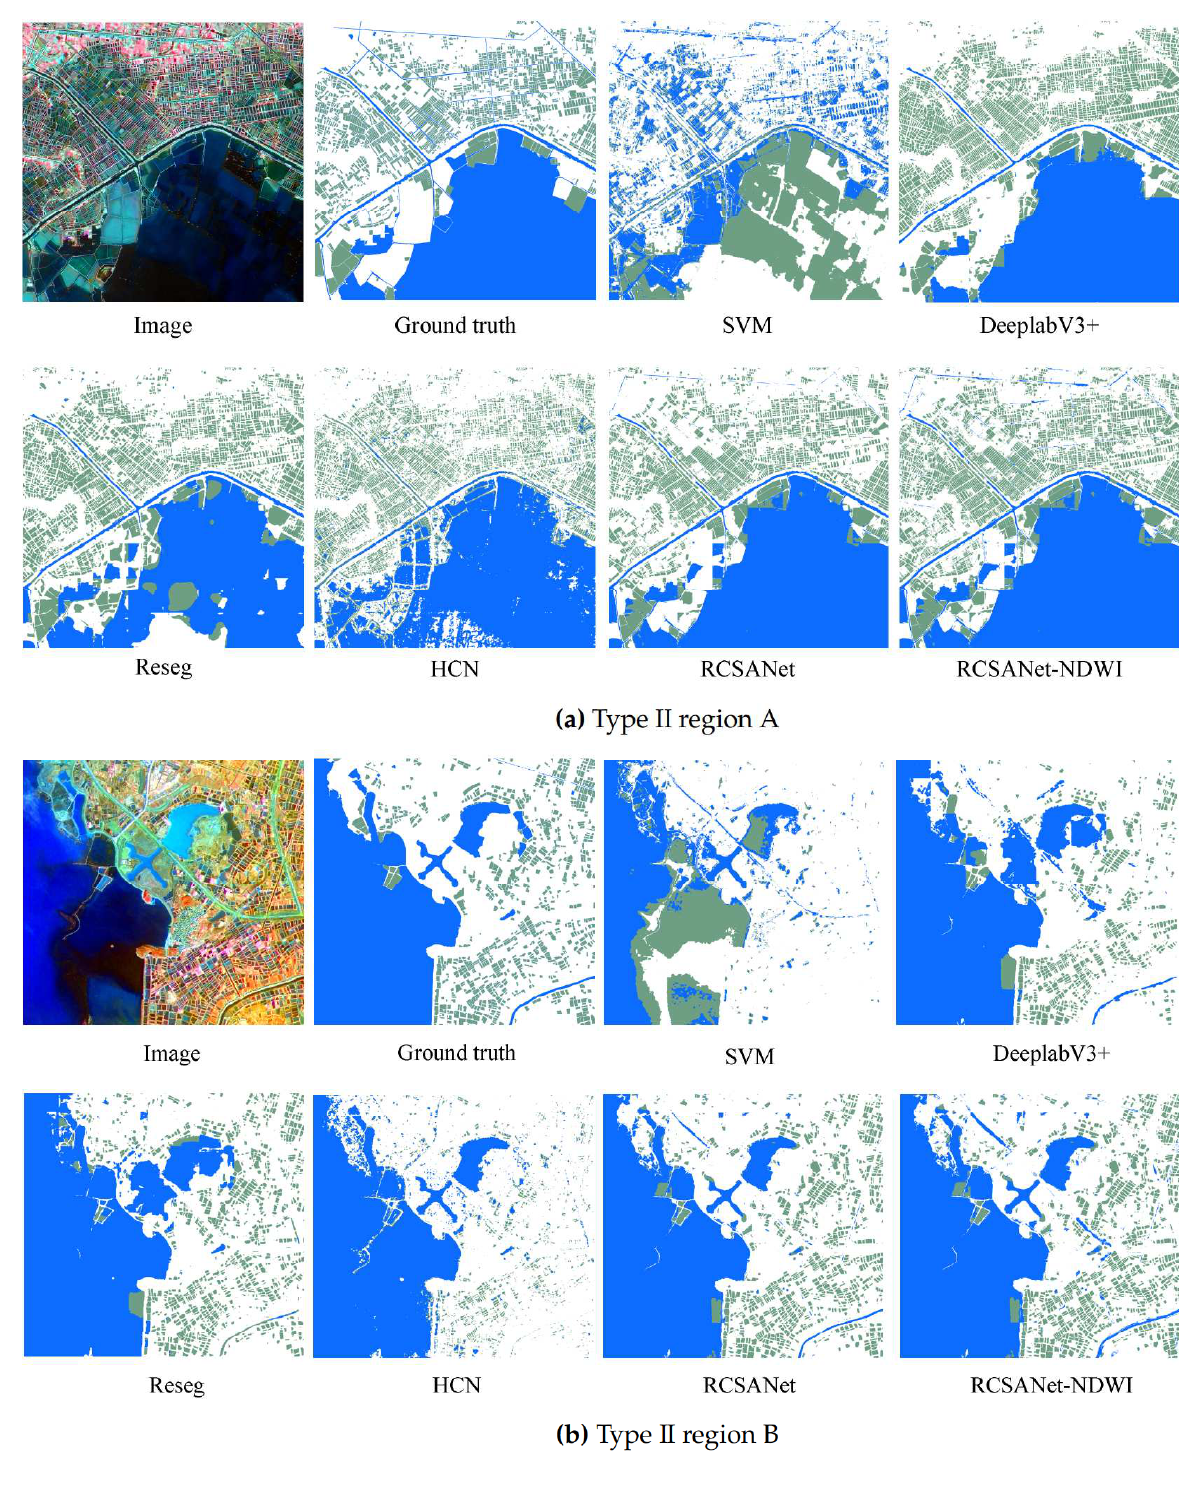
Figure 8. Semantic segmentation results for aquaculture ponds and natural water bodies by various methods: ( a ) in region A, using the pansharpened image with the TM multispectral image captured in January 2011 and the ZY-3 panchromatic image in January 2013; and ( b ) in region B, using the pansharpened image with the OLI multispectral image captured in February 2014 and the GF-1 panchromatic image in January